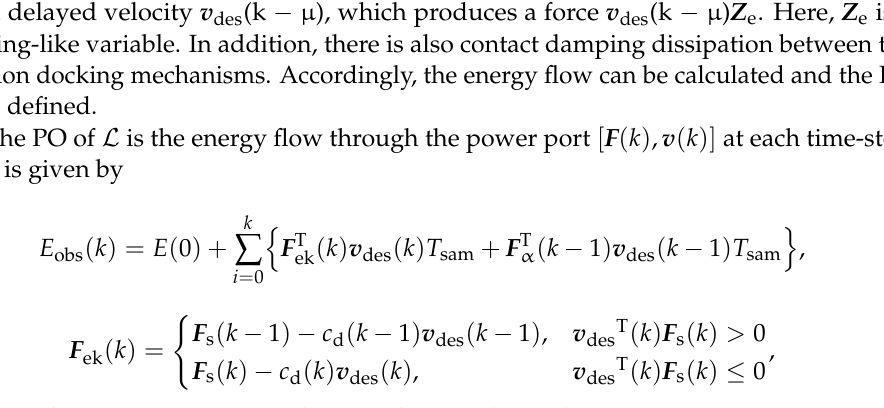
Figure 7. Modelling in electrical domain with velocity conserving.